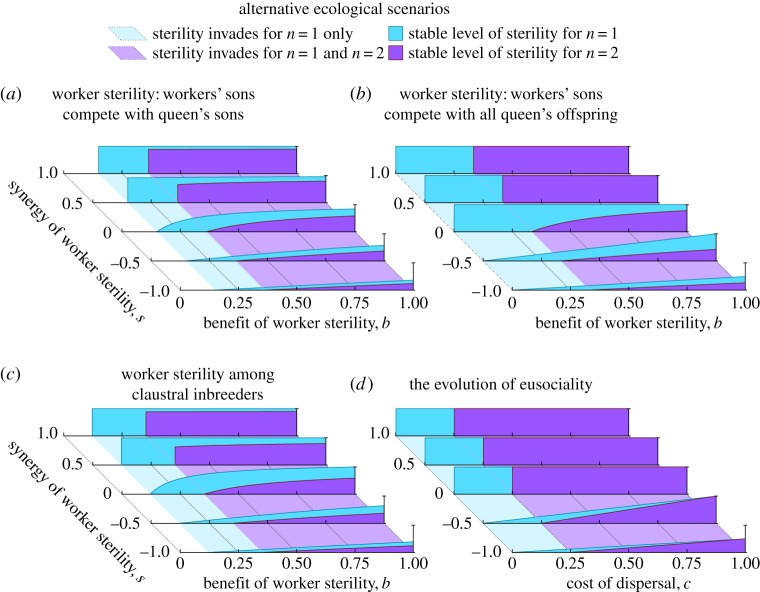
The evolution of worker sterility under alternative ecological scenarios. Here, we determine the stable level of worker sterility under four demographically explicit models of worker sterility; see Methods for full details. (a) One possible assumption is that worker-laid males only compete with the queen’s sons (cf. [19]). In this case, monogamy promotes worker sterility relative to promiscuity. (b) It is also possible to assume that worker-laid males compete with the queen’s offspring of both sexes, and not just with the queen’s sons. In this case, monogamy promotes worker sterility relative to promiscuity. (c) In the gall-forming thrips, the foundress produces an initial brood of female and male soldiers, who may produce part of the next brood by inbreeding among themselves [39]. Female soldiers can sacrifice part of their reproductive potential to invest more in defending their nestmates. In this case, monogamy promotes worker sterility relative to promiscuity. (d) A possible model for the evolution of eusociality involves dispersing, fully reproductive females evolving into sterile workers, who stay in the nest to help, producing no offspring [8–10]. In this case, monogamy promotes worker sterility relative to promiscuity. We show results for k=4 in (a) and k=2 in (b) and (c) (see Methods for details).